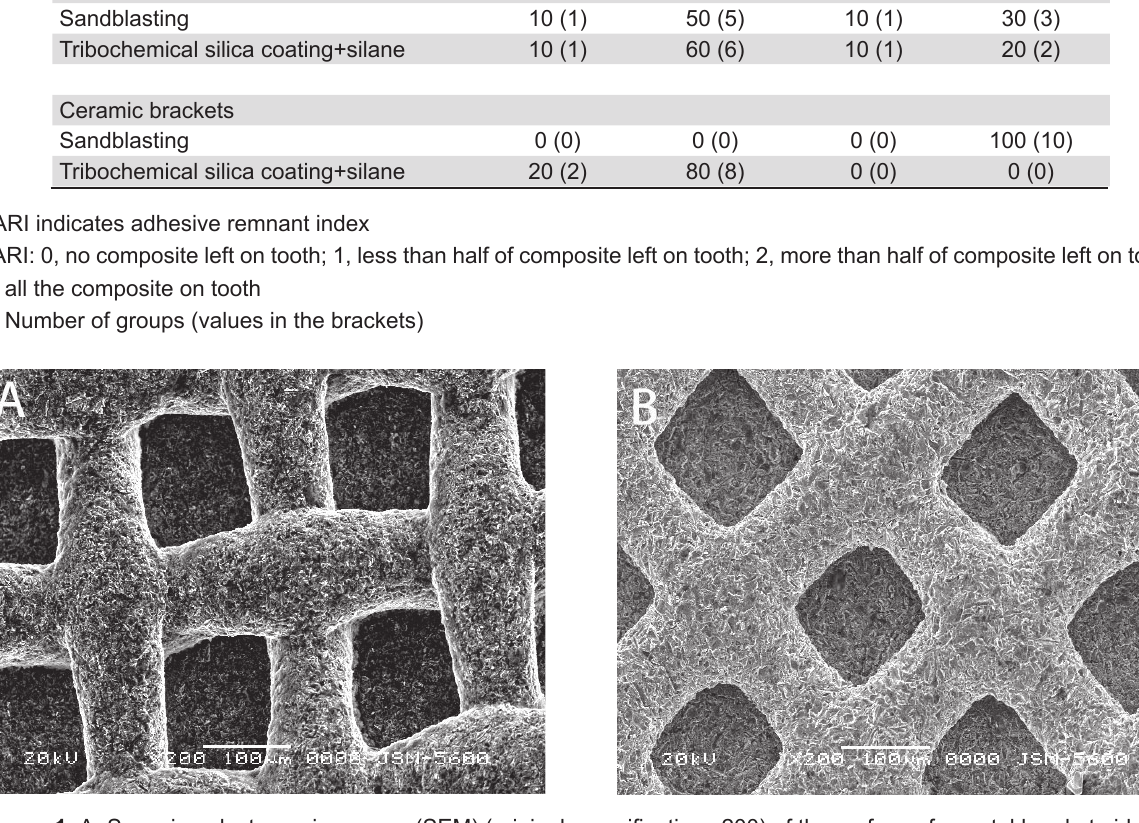
Figure 1- A, Scanning electron microscope (SEM) (original magnification x200) of the surface of a metal bracket airborne - particle abraded with 50-µm Al O (Group SB). B, SEM image (original magnification x200) of the surface of a metal 2 3